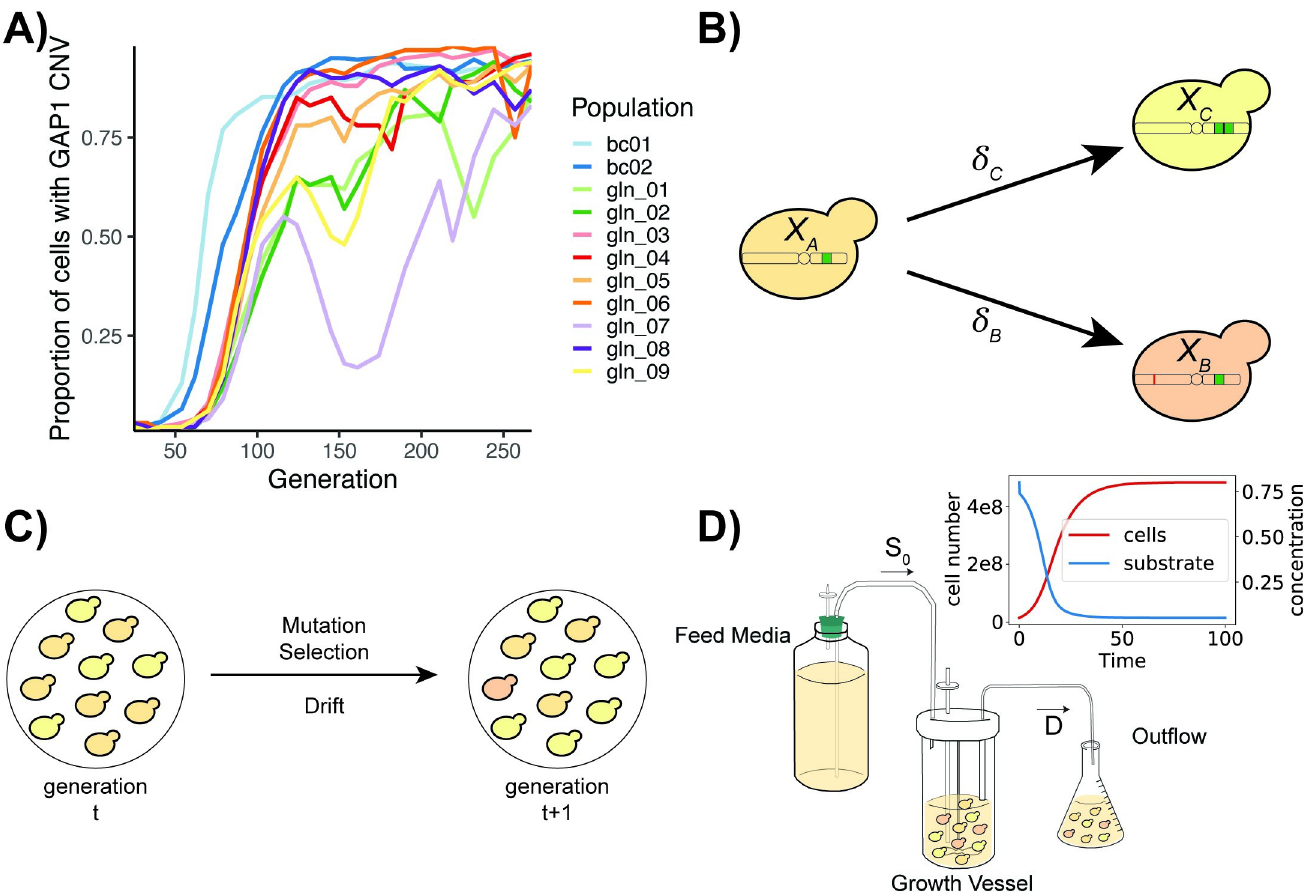
Fig 1. Empirical data and evolutionary models. (A) Estimates of the proportion of cells with GAP1 CNVs for 11 S . cerevisiae populations containing either a fluorescent GAP1 CNV reporter (gln_01 to gln_09) or a fluorescent GAP1 CNV reporter and lineage tracking barcodes (bc01 and bc02) evolving in glutamine- limited chemostats, from [48]. (B) In our models, cells with the ancestral genotype ( X ) can give rise to cells with a GAP1 CNV ( X ) or other beneficial mutation A C ( X B ) at rates δ C and δ B , respectively. (C) The WF model has discrete, nonoverlapping generations and a constant population size. Allele frequencies in the next generation change from the previous generation due to mutation, selection, and drift. (D) In the chemostat model, medium containing a defined concentration of a growth-limiting nutrient (S 0 ) is added to the culture at a constant rate. The culture, containing cells and medium, is removed by continuous dilution at rate D . Upon inoculation, the number of cells in the growth vessel increases and the limiting-nutrient concentration decreases until a steady state is reached (red and blue curves in inset). Within the growth vessel, cells grow in continuous, overlapping generations undergoing mutation, selection, and drift. Data and code required to generate A can be found at https://doi.org/10.17605/OSF.IO/E9D5X. CNV, copy number variant; WF, Wright–Fisher.